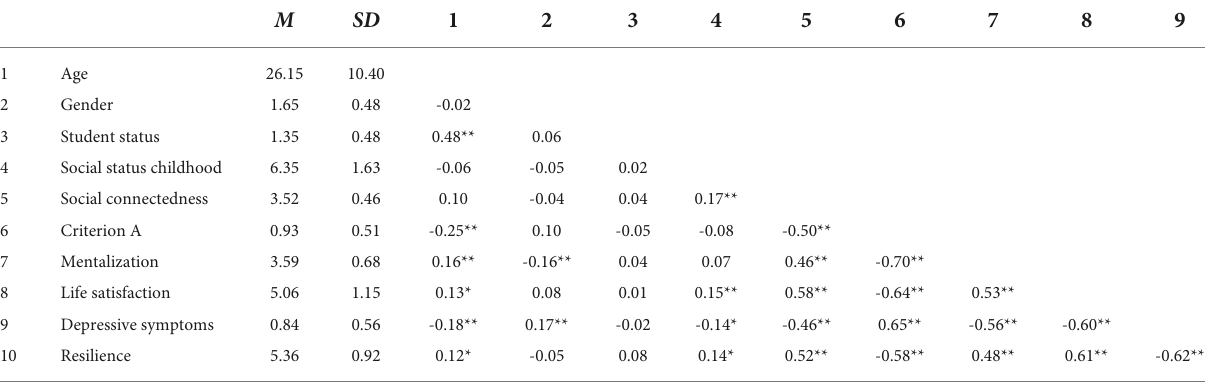
TABLE 1 Descriptive statistics and correlations between age, sex, student status, social status in childhood, social connectedness, Criterion A, mentalization, depressive symptoms, life satisfaction, and